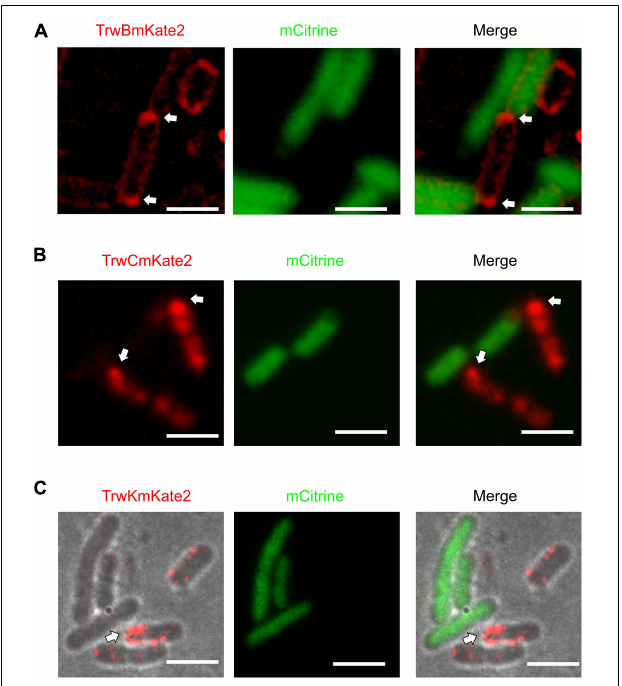
FIGURE 3 | Localization of conjugative proteins in the presence of recipient cells. MG1655 donor cells expressing TrwBmKate2 (A) , TrwCmKate2 (B) , and TrwKmKate2 (C) under their respective natural promotors in R388 plasmid were mixed with UB1637 recipient cells expressing the fluorescent protein mCitrine. Fluorescence of mKate2 protein derivatives in donors (red) and mCitrine (green) in recipients is shown on the left and central panels, recorded at 630 and 540 nm, respectively. The right panel shows the merged images. Upon contact between both donor and recipient cells, the conjugative fluorescent proteins localize at the poles, on those specific areas that are in close contact with a recipient cell. In panel C, phase contrast/color bright field images are shown to better visualize both, the foci and the bacterial cells. The arrow shows the areas in the donor cell where the conjugative ATPases are compiled upon contact with the recipient cell. [Scale bars: 2 µ M (A) and 3 µ M (B,C) ].